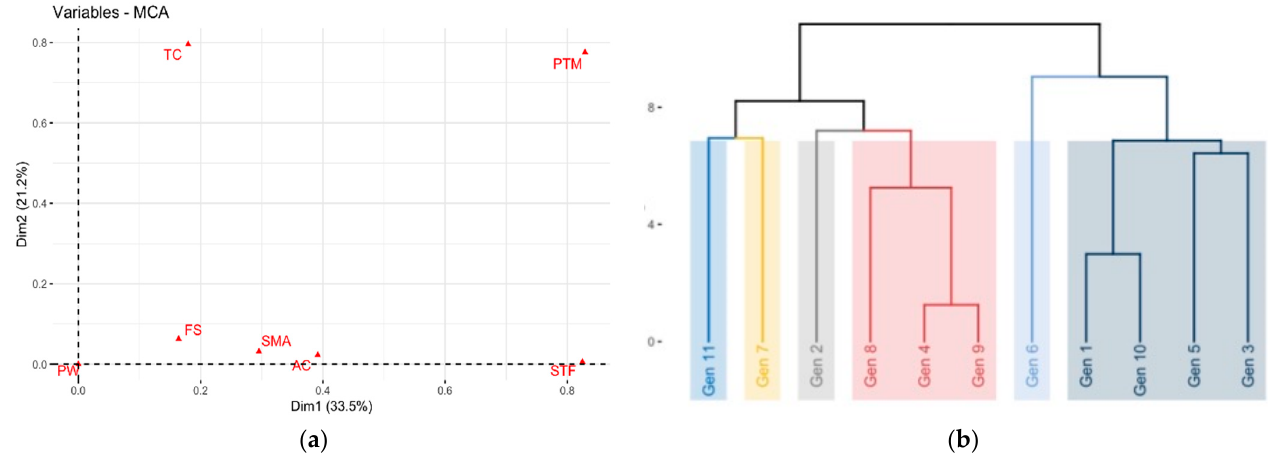
Figure 4. ( a ) Mixed factor analysis shows the contribution of the variables, ordering the materials according to the qualitative and quantitative variables. ( b ) Cluster analysis. showing six groups of materials formed according to qualitative and quantitative variables.